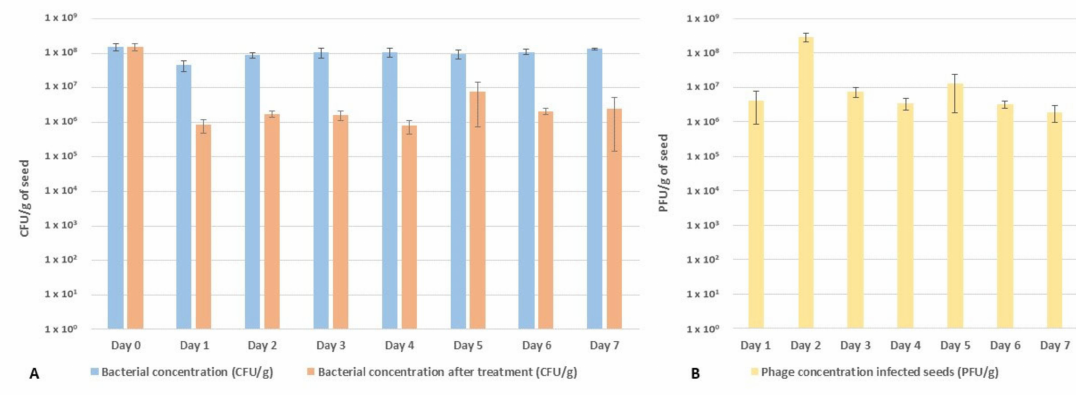
Figure 3. Monitoring bacterial and phage concentration during seed priming. ( A ) The bacterial titer (CFU / g seed) was followed as a function of time during a seven-day priming experiment in three independent repeats of non-treated and treated seeds in blue and orange, respectively. At day 0, the bacterial concentration was 10 8 CFU / g. The bacterial titer dropped 100-fold in the infected seeds after treatment with phages at a final concentration of 10 9 PFU / mL and remained stable over the course of the priming. ( B ) Phage titer (PFU / g seed) was followed over time in infected seeds. Twenty-four hours after treatment, the concentration of phage was 10 6 PFU / g and increased after 48 h to 10 8 PFU / g. After 72 h, the concentration dropped again to 10 7 PFU / g and remained quite stable until day 7 (10 6 PFU /